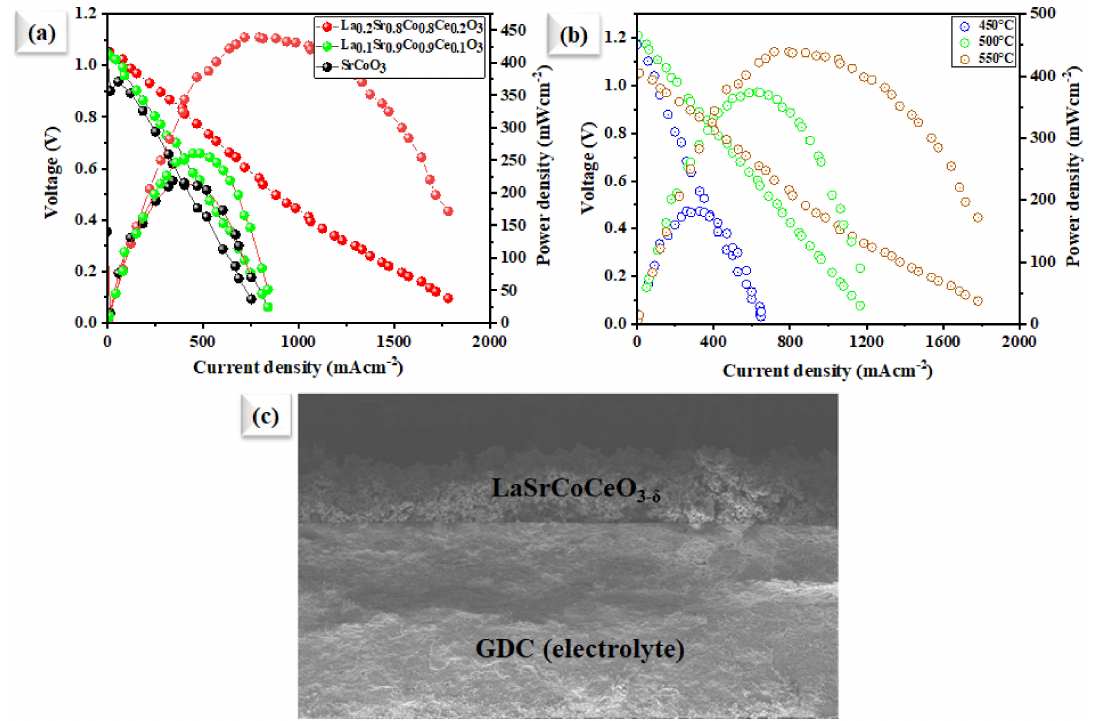
Figure 6. ( a ) Electrochemical performances: characteristics curves of the utilization of our Sr in com- parison with SrCoO 3 , La 0.1 Sr 0.9 Co 0.9 Ce 0.1 O 3 − δ and La 0.2 Sr 0.8 Co 0.8 Ce 0.2 O 3 − δ embedded on porous Ni-foam cathode in fuel cell operated at 550 ◦ C; ( b ) fuel cell performance using our prepared La 0.2 Sr 0.8 Co 0.8 Ce 0.2 O 3 − δ embedded on porous Ni-foam cathode under different operating tempera- tures of 450–550 ◦ C; ( c ) cross-sectional SEM images of tri-layer electrolyte supported fuel cell